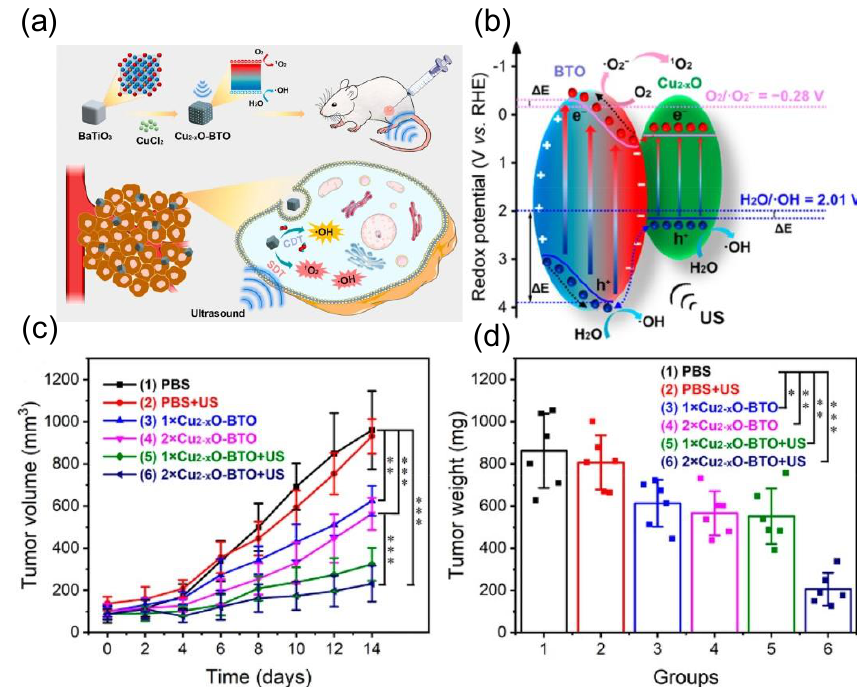
Figure 8. ( a ) Schematic diagram of the PEDT − CDT using BTO − Cu 2 − x O nanohybrid. ( b ) Mechanism of the ROS generation using BTO − Cu 2 − x O. ( c , d ) Average tumor growth curves of the mice and average tumor weight after the different treatments (*** p < 0.001, ** p < 0.01, * p < 0.05). Reproduced with permission [41] . Copyright 2022, American Chemical Society.